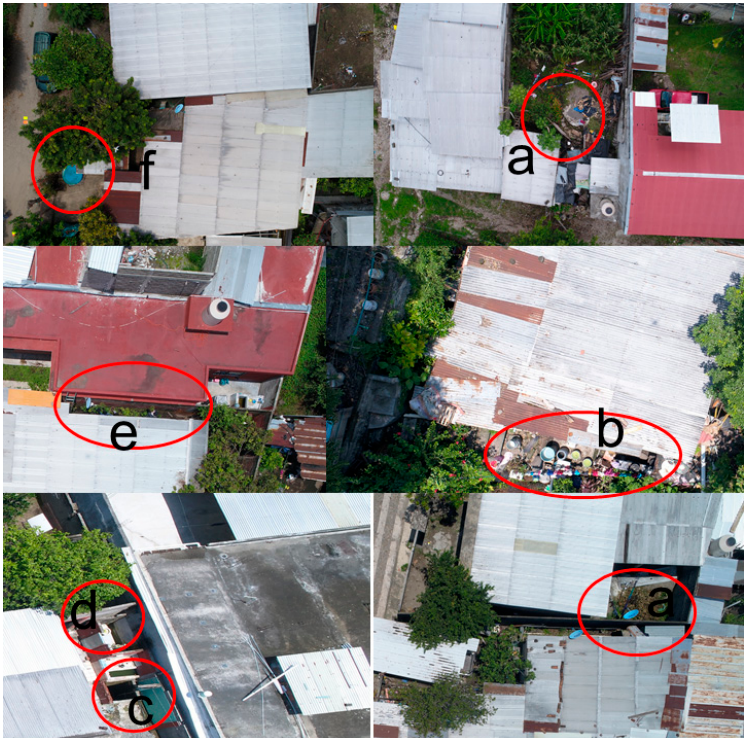
Figure 3. Drone images of larvae breeding sites in outdoor (backyard) areas of houses in El Vergel, Tapachula, Chiapas, in ( a ) disposable plastic container; ( b ) plastic buckets and tubs; ( c ) cement washbasins (large); ( d ) WCs; ( e ) flowerpots; and ( f ) other (pools).